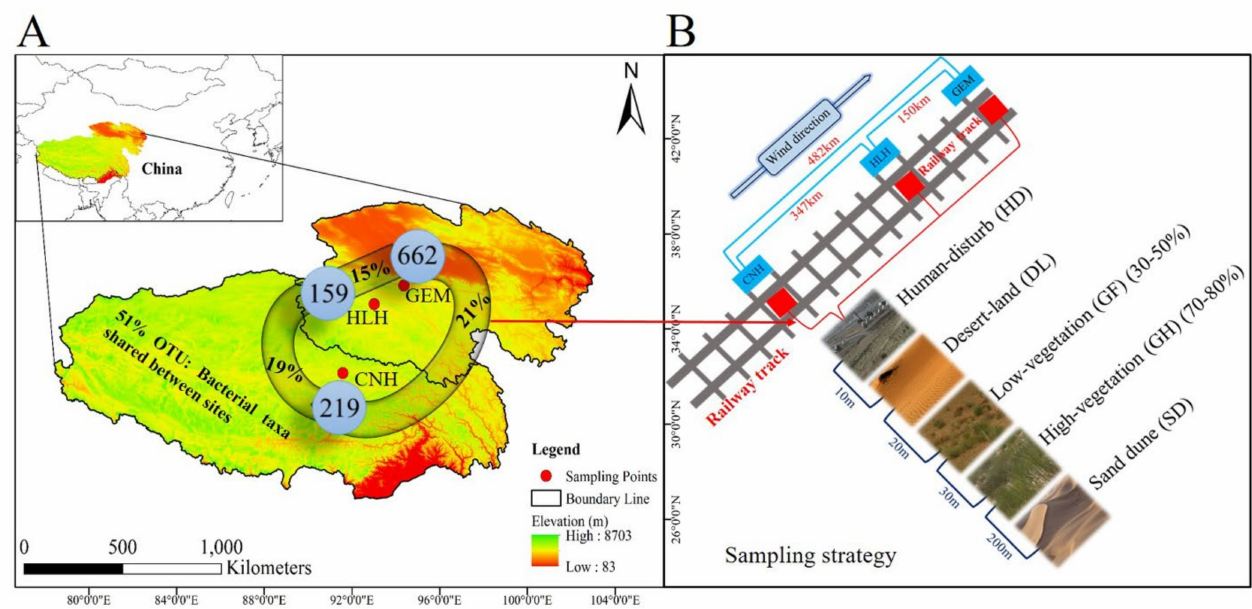
Figure 1. Site biogeography in the bacterial community: ( A ) Map of the Qinghai Tibetan Plateau, China. Geographical distribution of 3 sites where bacterial diversity samples and soil data were collected (Table S1) and showing the operational taxonomic units (OTUs) found in each site (circles) and the percentages shared between different sites (lines) (Figure S2). Shared-OTUs estimates for site pairs are shown. ( B ) Sampling strategy showing the individual soil sample collected (Table S1). CNH—CuoNaHu, HLH—HongLiangHe,